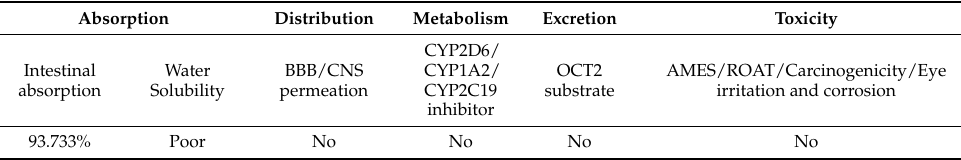
Table 6. Calculated ADMET properties of the natural compound ( β -Amyrin). Absorption